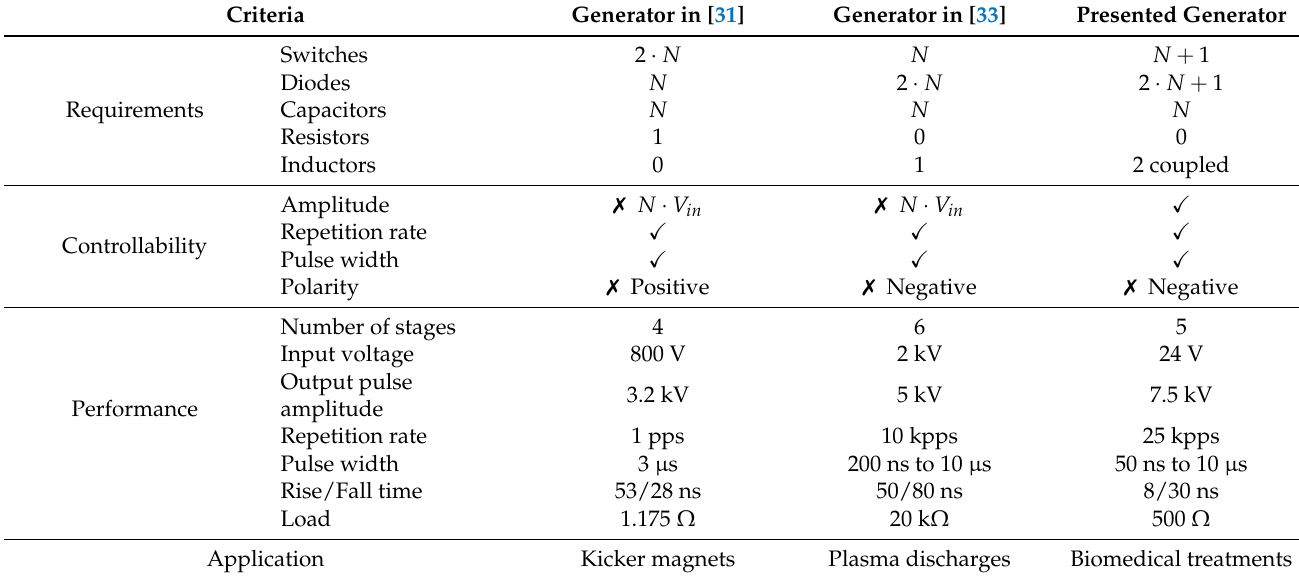
Table 1. Summary and comparison.